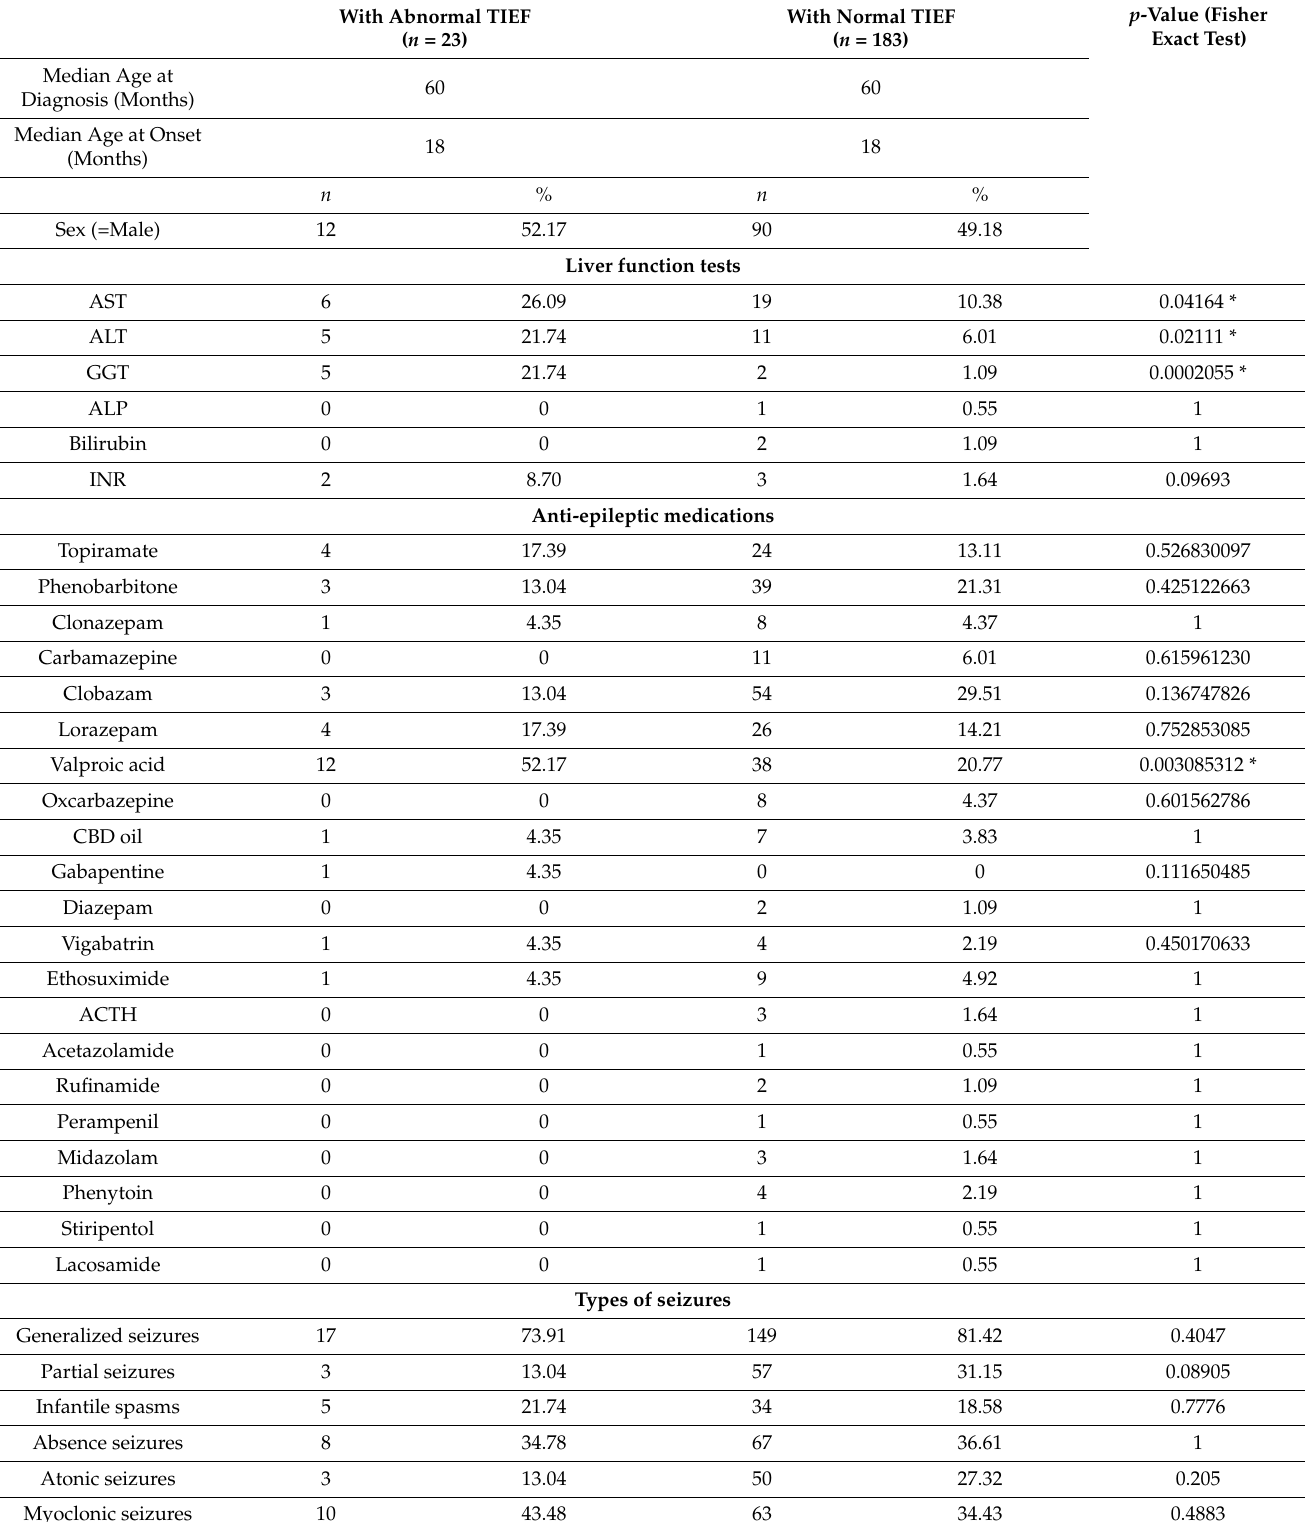
Table 2. Comparison of patients with abnormal or normal transferrin isoelectric focusing for their demographics, seizure types, anti-epileptic medications, and liver functions. With Abnormal TIEF ( n = 23)